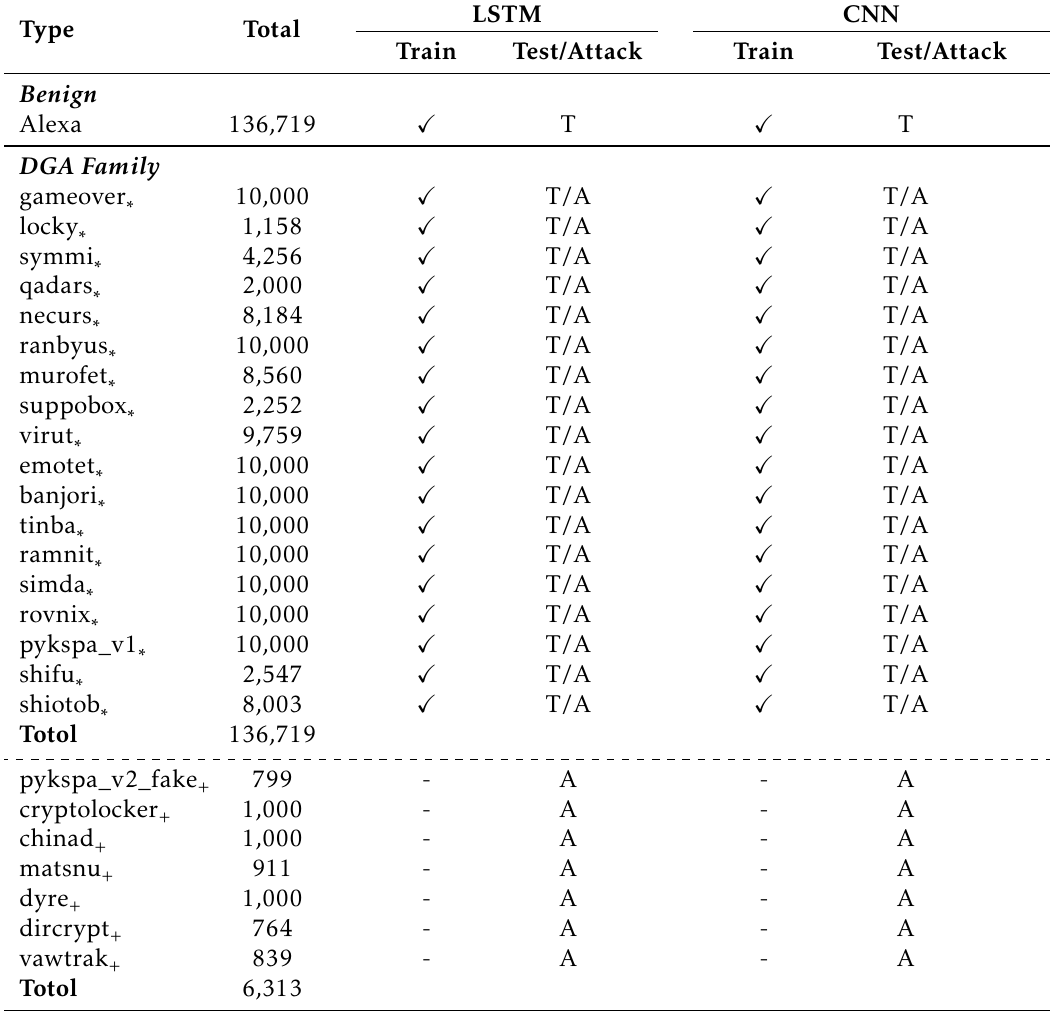
Table 1. Datasets for evaluating CLETer